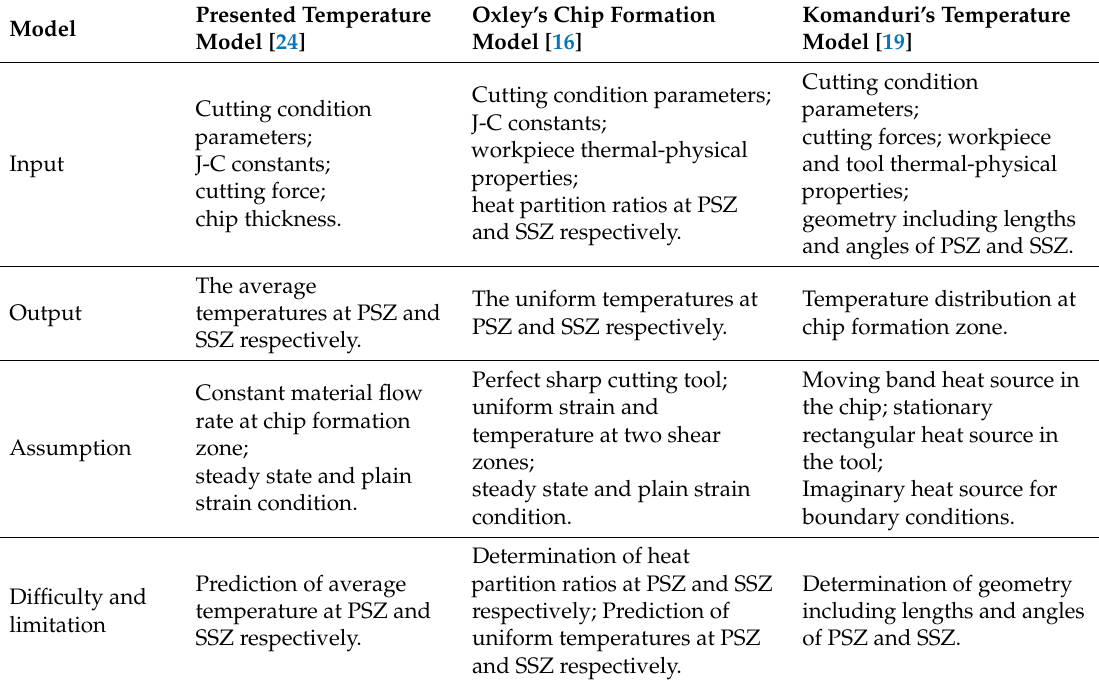
Table 7. Comparison of three analytical temperature prediction